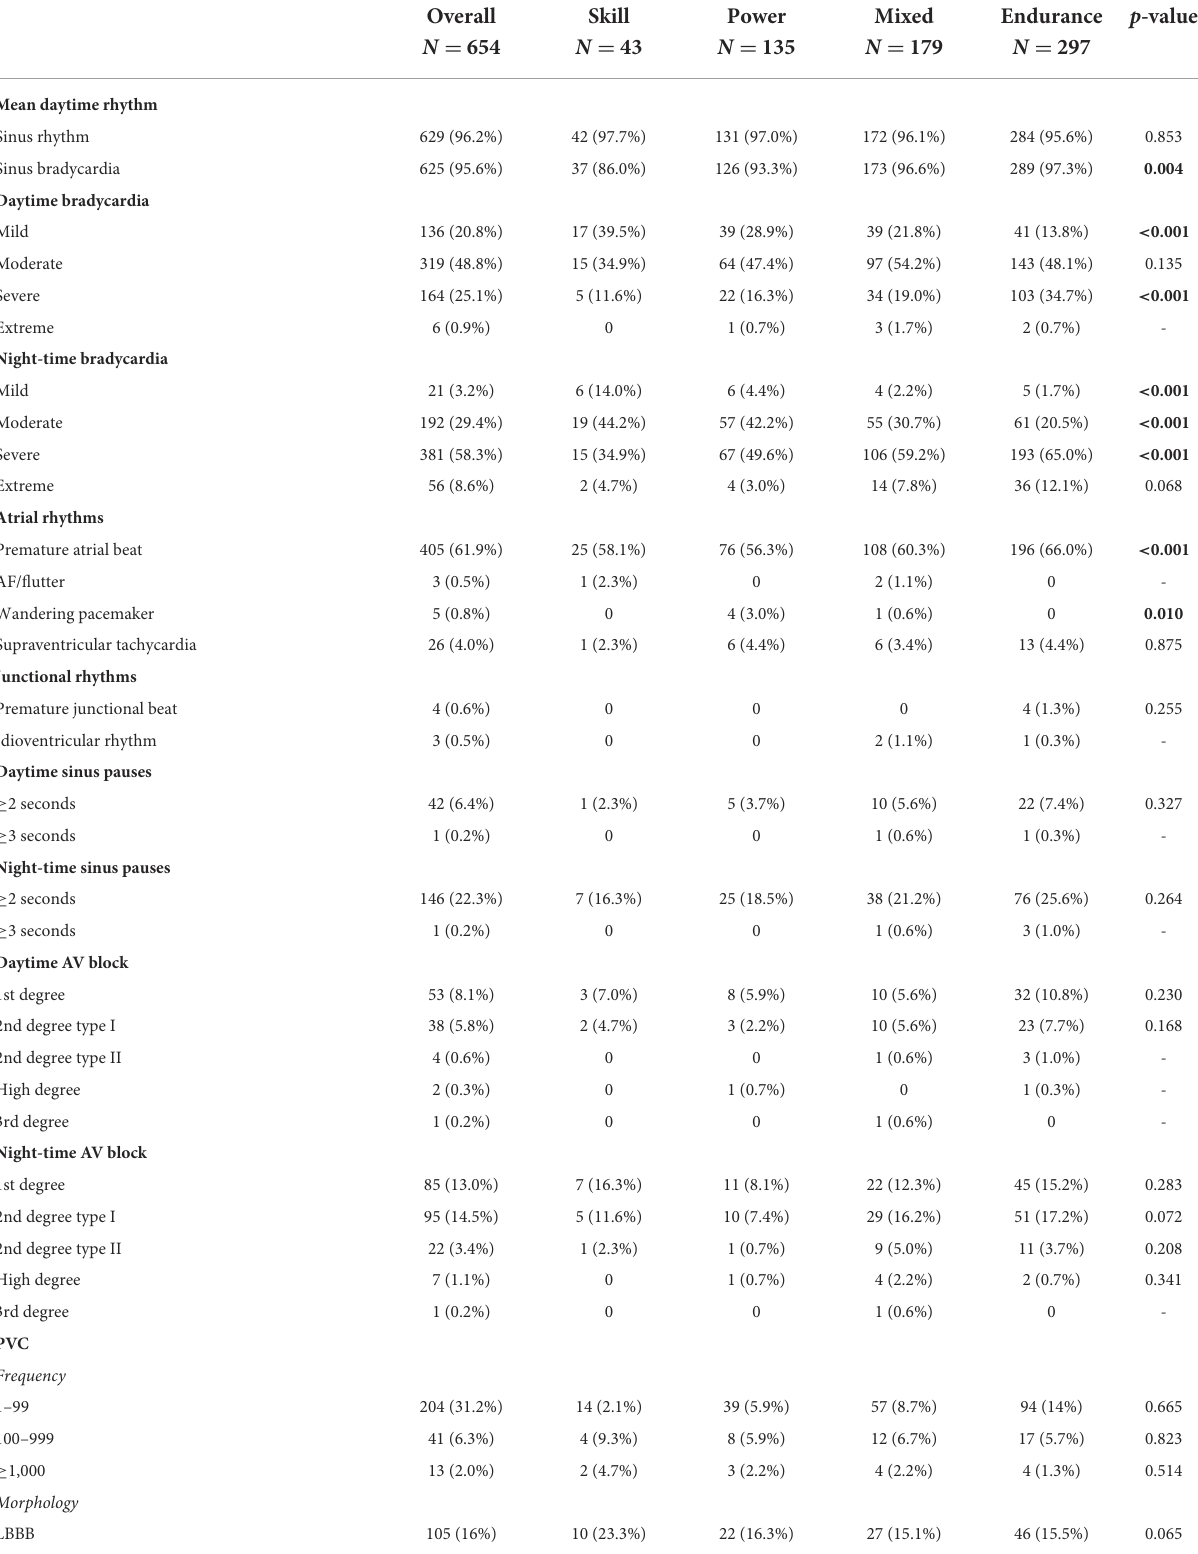
TABLE 2 Cardiac rhythm alterations during Holter